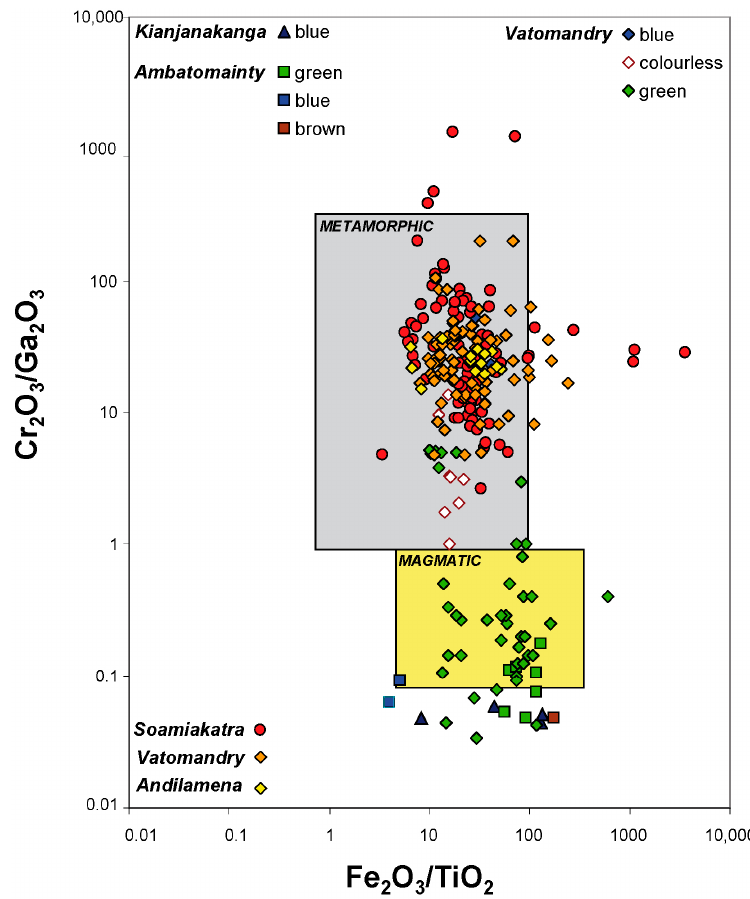
Figure 16. Cr 2 O 3 / Ga 2 O 3 versus Fe 2 O 3 / TiO 2 diagram for rubies and sapphires associated with alkali basalts from the Antananarivo and Toamasina Provinces in Madagascar. The metamorphic and magmatic boxes defined for Australian sapphires are from [68,75].